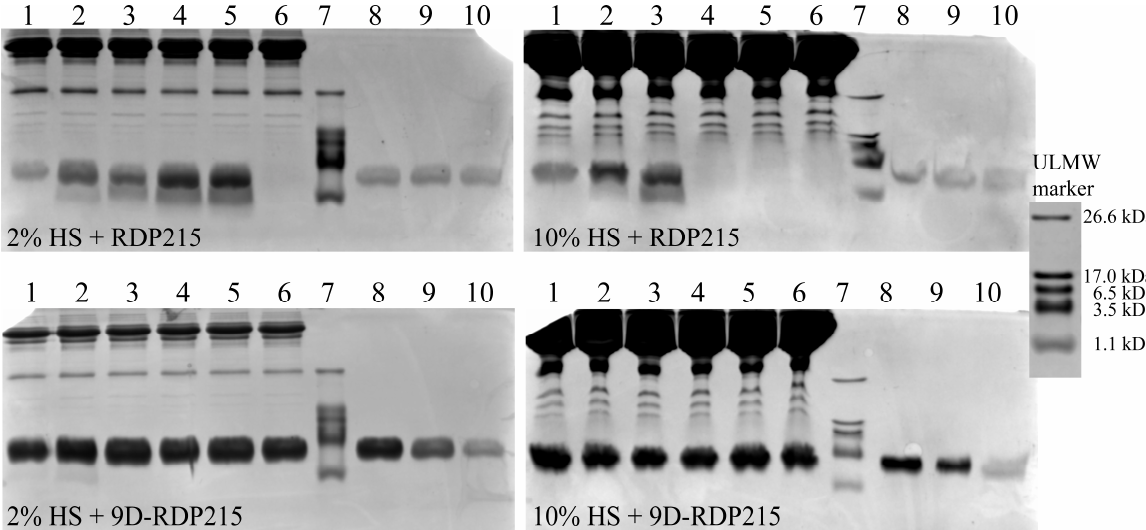
Figure 8. SDS-polyacrylamide gel electrophoresis of stability studies of RDP215 ( top ) and 9D-RDP215 ( bottom ) in the presence of 2% and 10% human serum (HS). Peptides (2.5 µg per sample) were incubated at 37 °C for up to 7 days in the presence of 2% and 10% HS, respectively. Two percent HS ( left ) and 10% HS ( right ): Lane 1–6: 2.5 µg of the respective peptide was incubated in the presence of 2% HS or 10% HS for 0 h (lane 1), 1 h (lane 2), 8 h (lane 3), 24 h (lane 4), 2 days (lane 5) and 7 days (lane 6). Molecular weights can be estimated from the ULMW marker (lane 7), and fragment sizes are given on the right. Lane 8–10: 2.5 µg, 1 µg and 0.5 µg of the respective peptide control. Presented data are representative of the results of at least two independent measurements. While 9D-RDP215 does not show any peptide degradation in the presence of 2% or 10% HS, RDP215 already shows degradation within 7 days (lane 5) of incubation in the presence of 2% and already within 24 h (lane 4) in the presence of 10% HS.